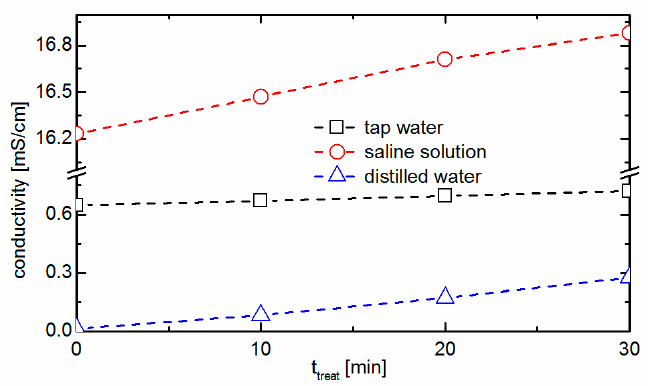
Figure 7. Change of conductivity with treatment time.